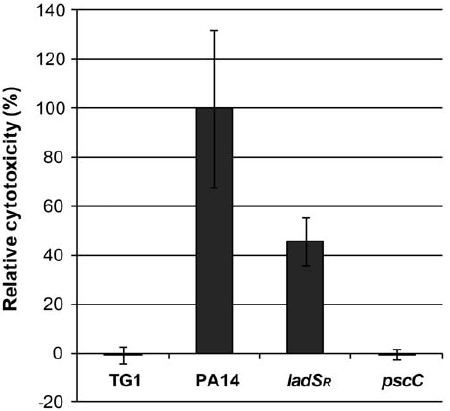
Figure 5. Lactate dehydrogenase (LDH) release of HeLa cells infected with the indicated bacterial strains for 1 hour. The LDH release of PA14 has been set to 100%. Data are representative of three independent experiments. The difference between PA14 and ladS R is significant with p=0.018.